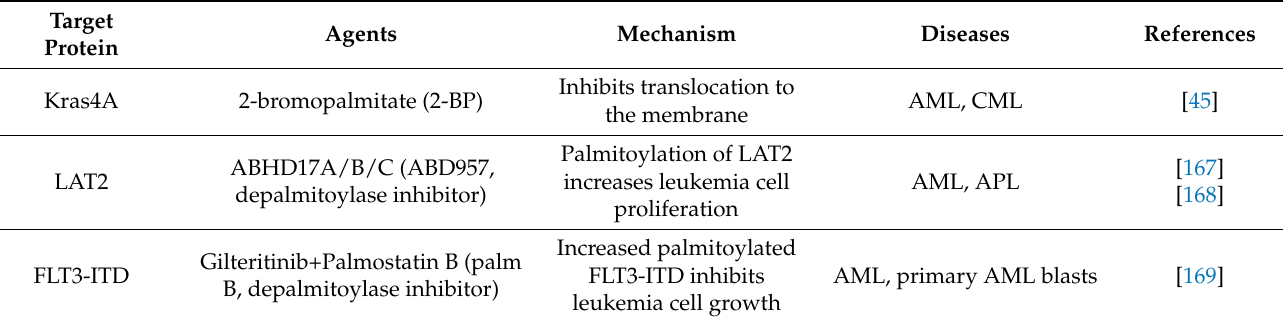
Table 2. Potential therapies targeting palmitoylation in